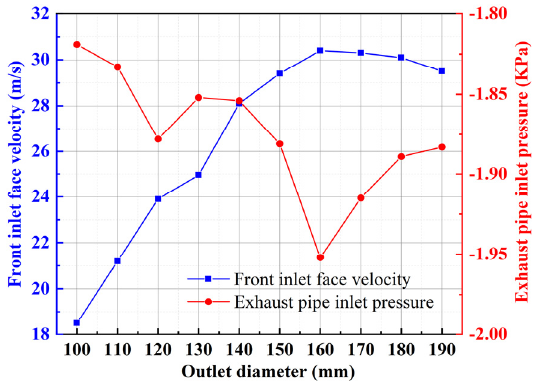
Figure 11. Influence of outlet diameter on flow field characteristics.